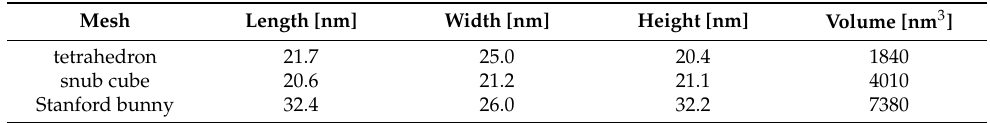
Table 1. Dimensions of input triangular mesh for coating application.